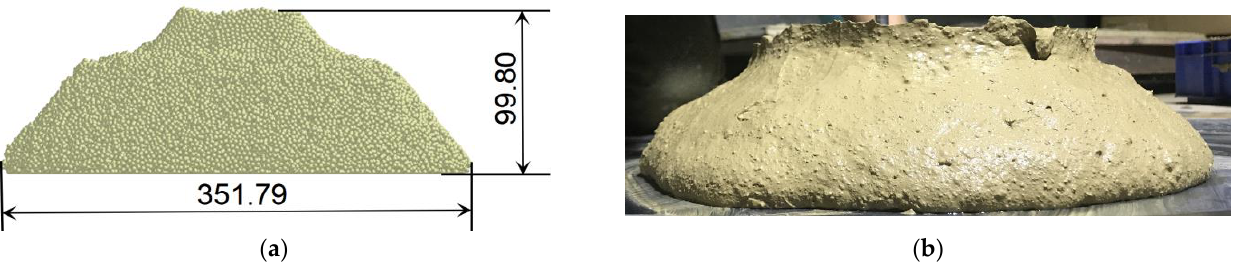
Figure 2. ( a ) Simulated slumping value (200-99.80 mm) and slumping expansion (351.79 mm) in the DEM model with optimized parameters; ( b ) measuring slumping value and slumping expansion in the lab. Table 8. Validation test.